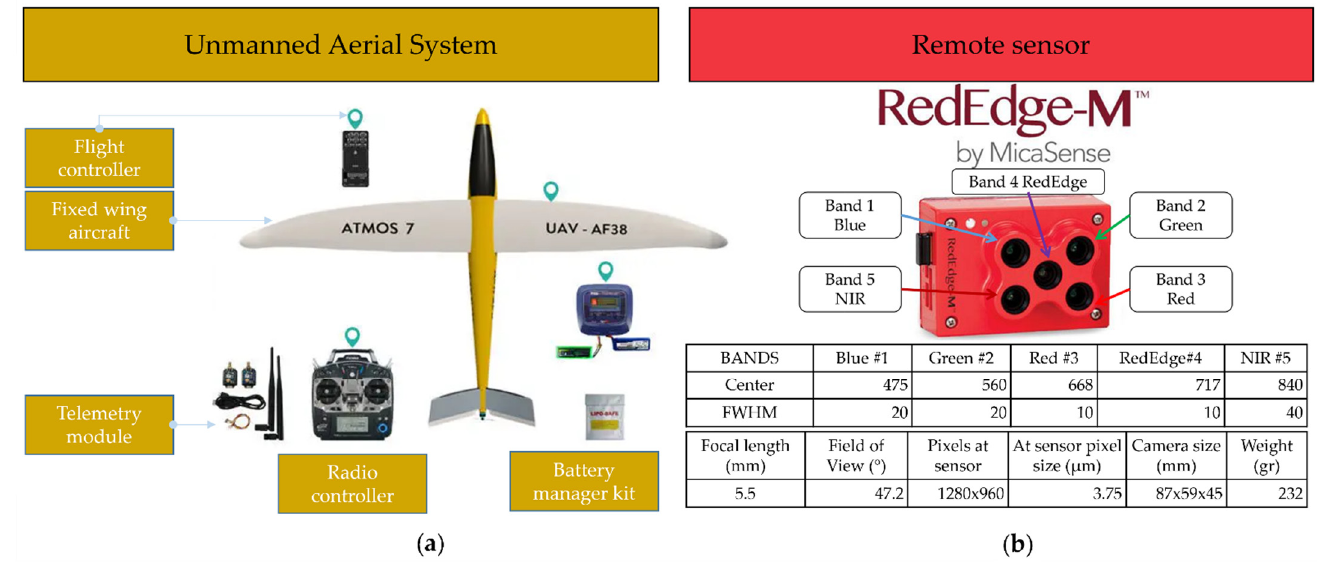
Figure 2. ( a ) Fixed-wing drone platform used for the mission. ( b ) Sensor used to capture aerial data.